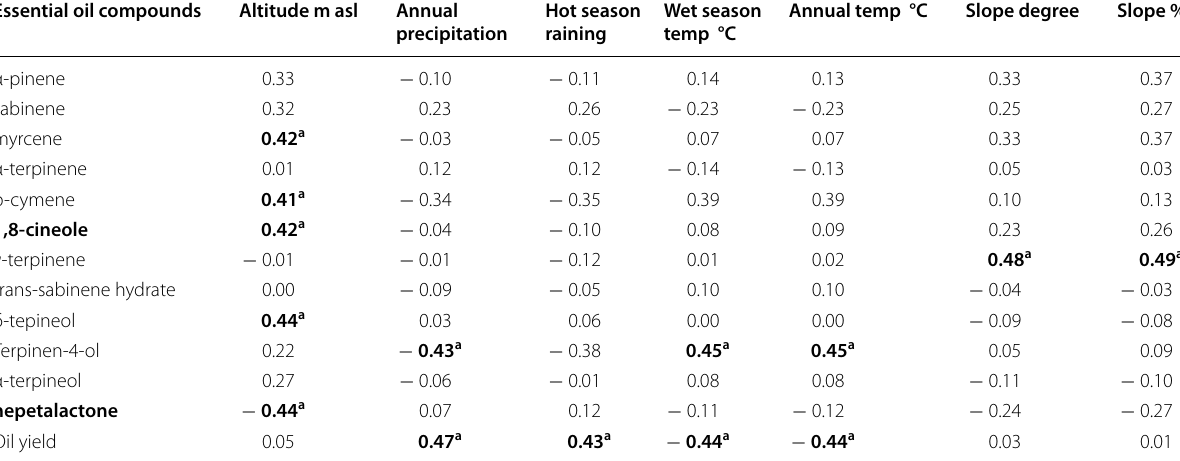
a significant at 5% probability levels =